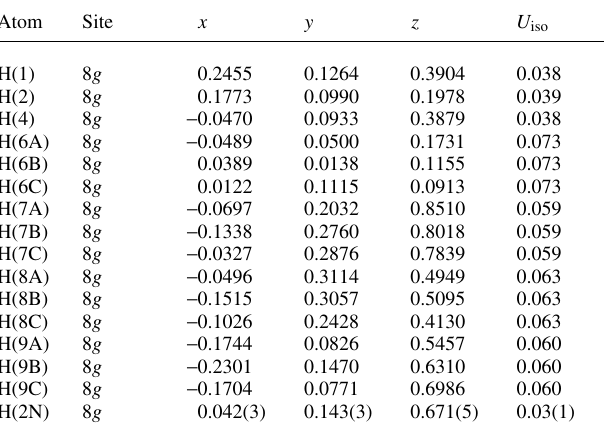
Table 2. Atomic coordinates and displacement parameters (in Å 2 )